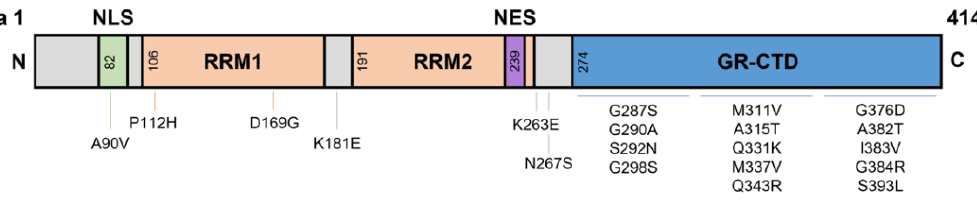
Figure 1. Domains of TDP-43 and known Single Nucleotide Polymorphism mutations. TDP-43 is a 43 kDa protein containing 414 amino acids. The NLS resides from aa82 – 98, with RRM1 and RRM2 residing at aa106 – 176 and aa191 – 259, respectively. The NES resides within RRM2 at aa239 – 250, and a GR-CTD is located at aa274 – 414. Most known single nucleotide polymorphisms reside on the GR-CTD. However, some mutations have been identified at the NLS and around the RRMs. aa, amino acid; NLS, nuclear localisation signal domain; RRM, RNA recognition motifs; NES, nuclear export signal; GR-CTD, glycine rich C-terminal domain.